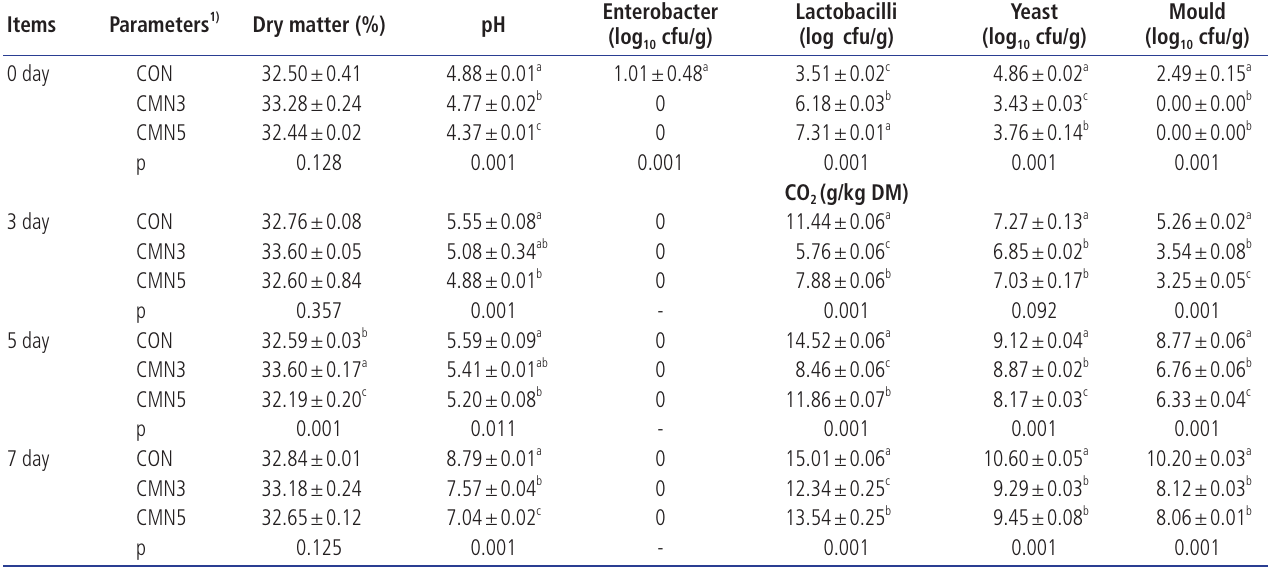
Table 5. Effects of cumin essential oils on overall composition of alfalfa silages after 7 days of aerobic exposure and on microbial counts